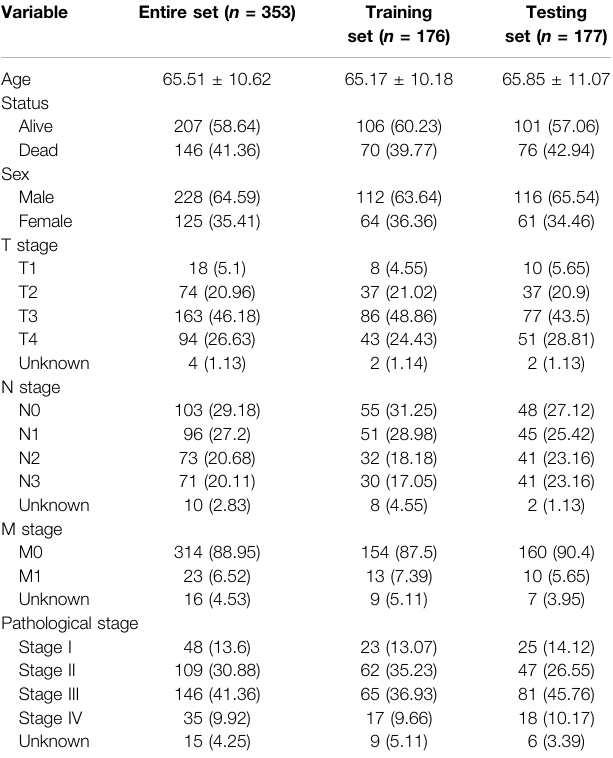
TABLE 2 | Clinical characteristics of GC patients from training, testing, and entire sets. Variable Entire set ( n =